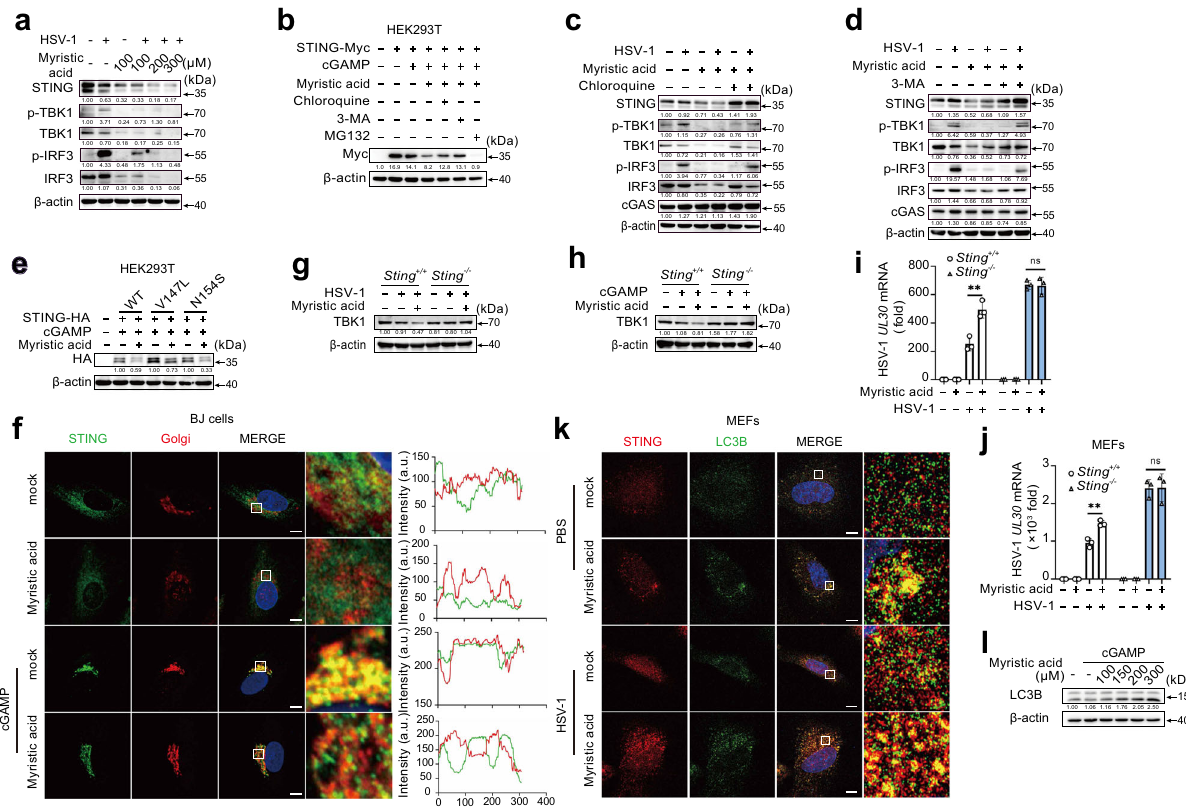
Fig. 4 | Myristic acid promotes STING-dependent autophagy. a Immunoblot analysis of indicated proteins in peritoneal macrophages (PMs) pretreated with increasingconcentrationsofmyristicacid,followingherpessimplexvirus1(HSV-1) infection. b Immunoblot analysis of STING expression in STING-Myc transfected HEK293T cells pretreated with chloroquine, 3-methyladenine (3-MA), or MG132, and then treated with myristic acid, following cyclic adenosine monophosphate (AMP) – guanine monophosphate (GMP) (cGAMP) stimulation. c , d Immunoblot analysis of indicated proteins in PMs pretreated with chloroquine ( c ) or 3-MA ( d ), and then treated with myristic acid, followed by HSV-1 infection. e Immunoblot analysisofSTINGexpressioninHEK293Tcellstransfectedwithemptyvector(ctrl), wild-type STING (WT), or STING mutants (V147L or N154S), and then treated with myristicacid, following cGAMPstimulation. f ConfocalanalysisofSTINGand Golgi in BJcellspretreatedwithsolvent(mock)ormyristicacid and thenstimulated with